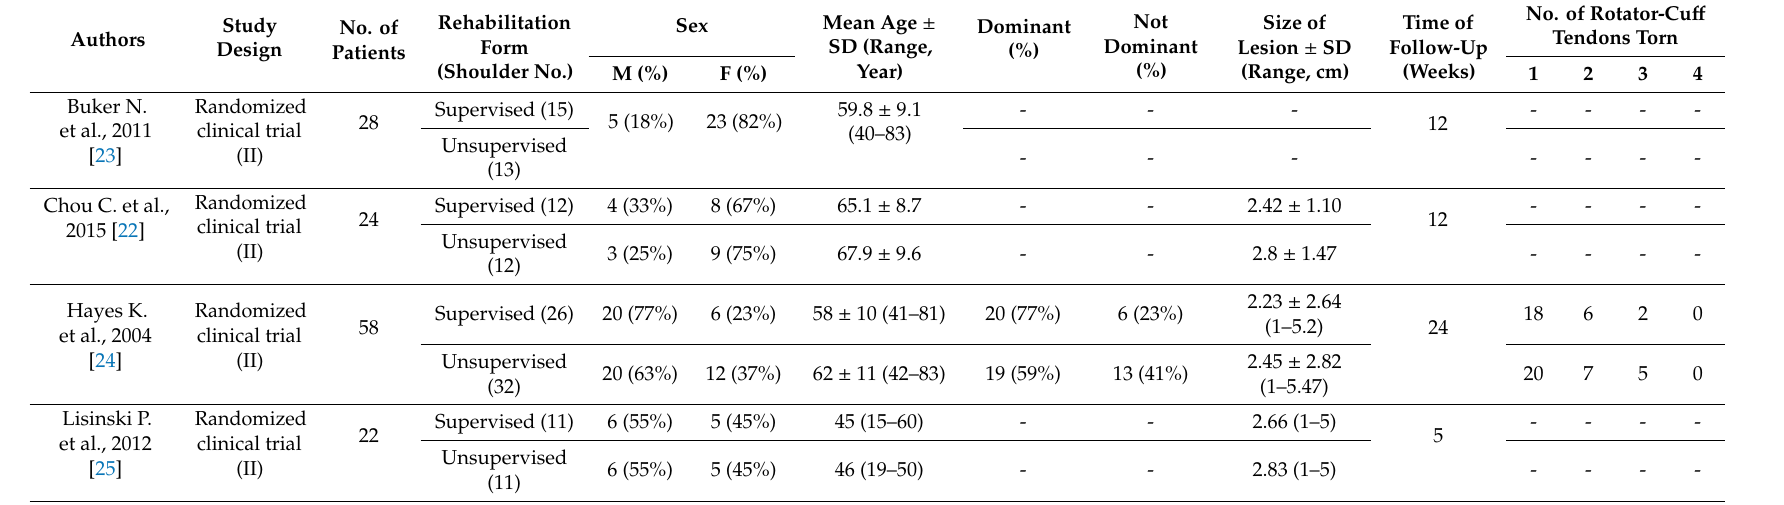
Table 1. Demographics and RC Tear